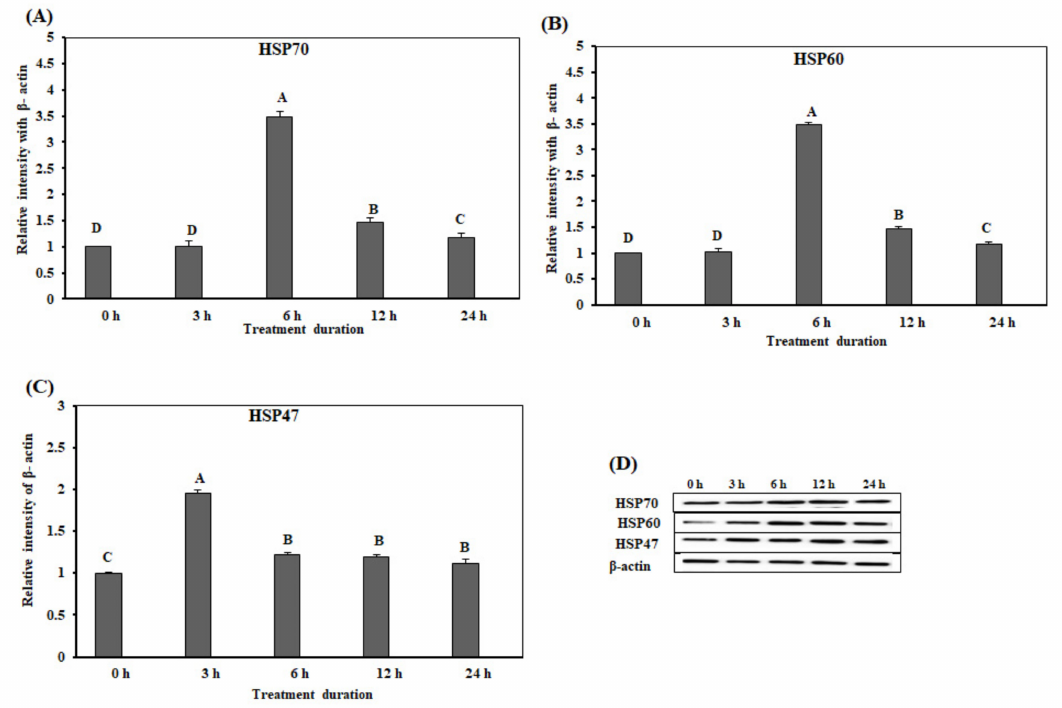
Figure 4. The expression of the heat shock proteins in the duodenum of chickens exposed to acute heat stress for di ff erent durations of time ( n = 8). The mean relative expression of HSP70 ( A ), HSP60 ( B ), and HSP47 ( C ). ( D ) Western blot analysis results. A–D HSP70 , HSP60 , and HSP47 in the columns with